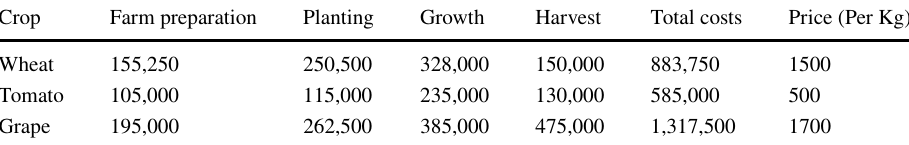
Table 8 Yield, WP, and WPe values in treatment and control